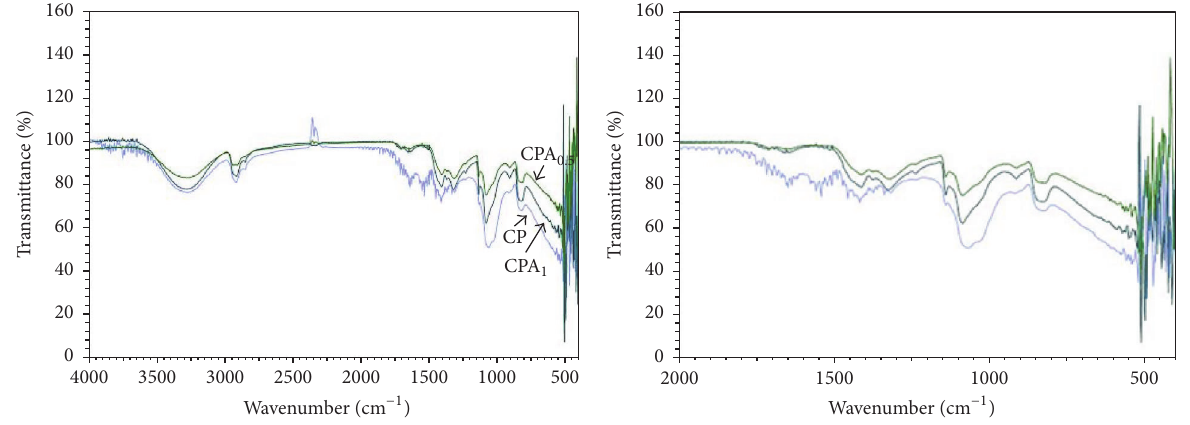
Figure 4: FT-IR spectra of CP, CPA 0.5 , and CPA 1 gels.